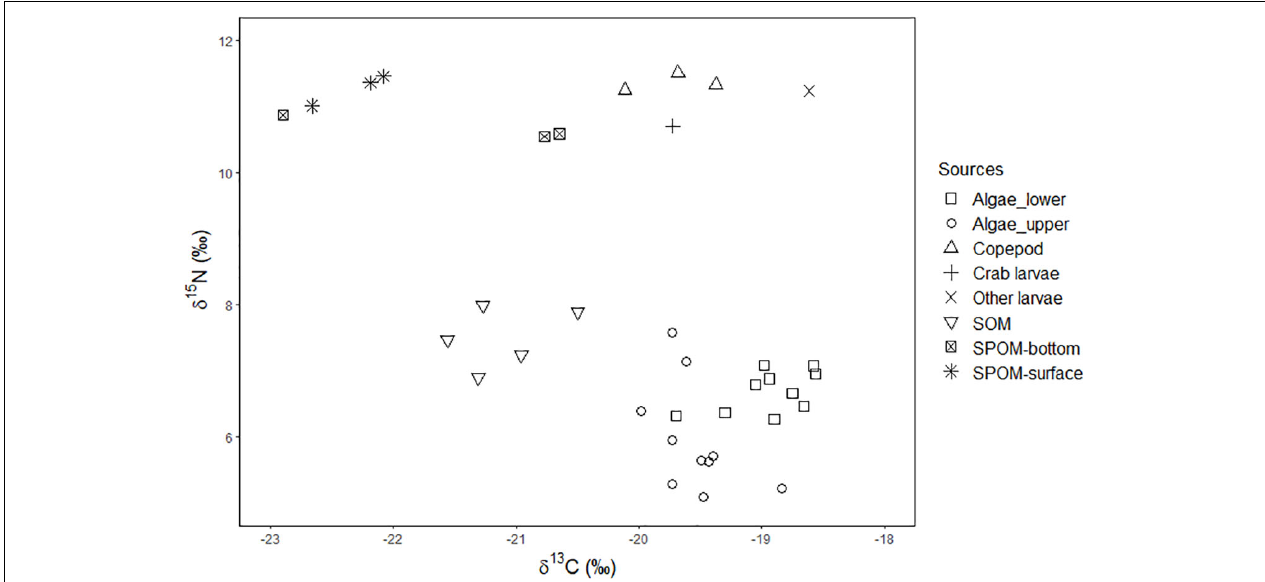
FIGURE 2 | Stable carbon ( δ 13 C) and nitrogen ( δ 15 N) isotopic values